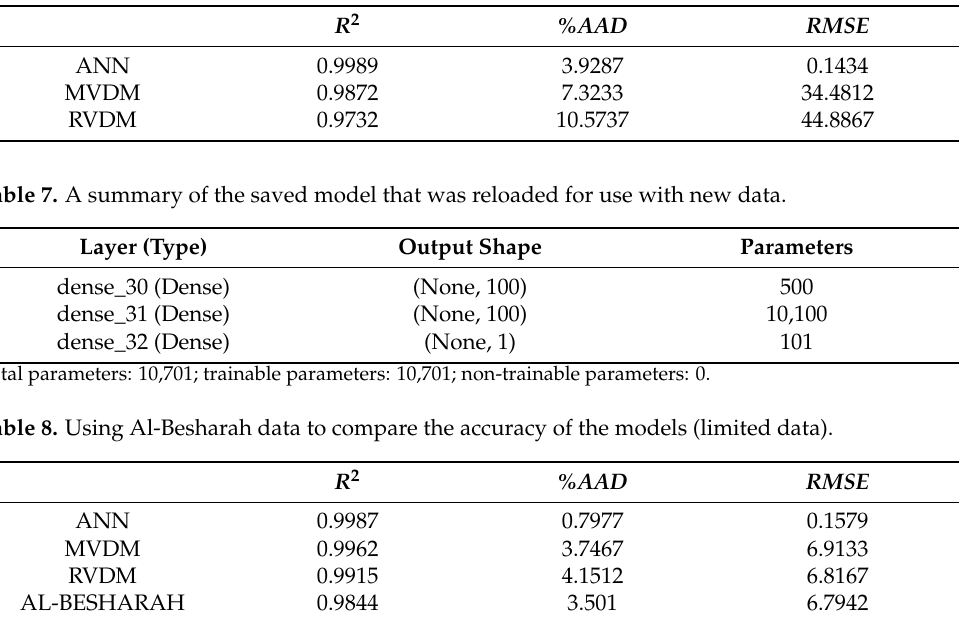
Figure 9. Comparison of the ANN- and empirical-model-predicted values to the literature data. For reference purposes, the ANN regression plots for the experimental and Al- Besharah data are presented in Figures 10 and 11, respectively. Figure 10. ANN regression plots for the experimental data. ( a ) Model Accuracy ( b ) Model Loss